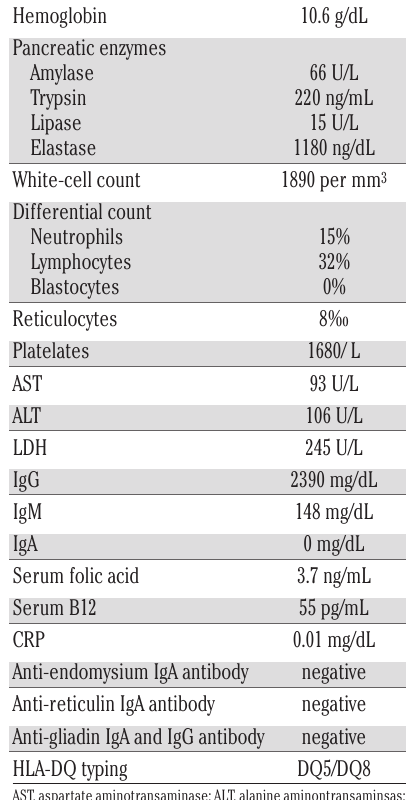
Table 1. Laboratory data on first admission.